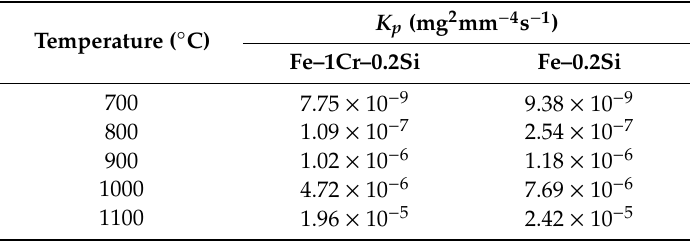
Table 5. K p values of the alloy obtained at di ff erent